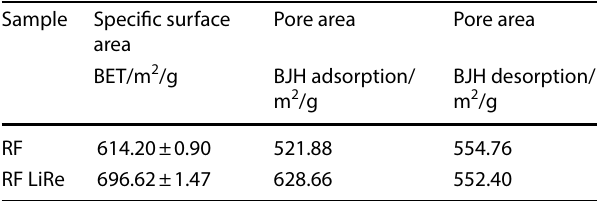
Table 1 Specific surface area and pore area calculated for carbon aerogels Sample